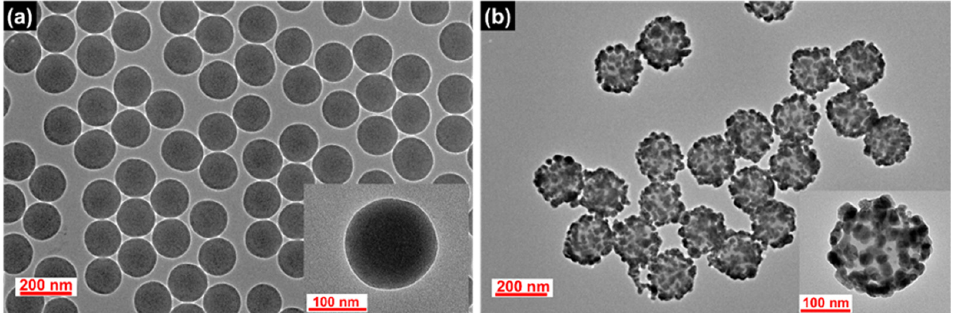
Figure 1. TEM images of the synthesized ( a ) SiO 2 NPs and ( b ) SiO 2 @Ag NPs.